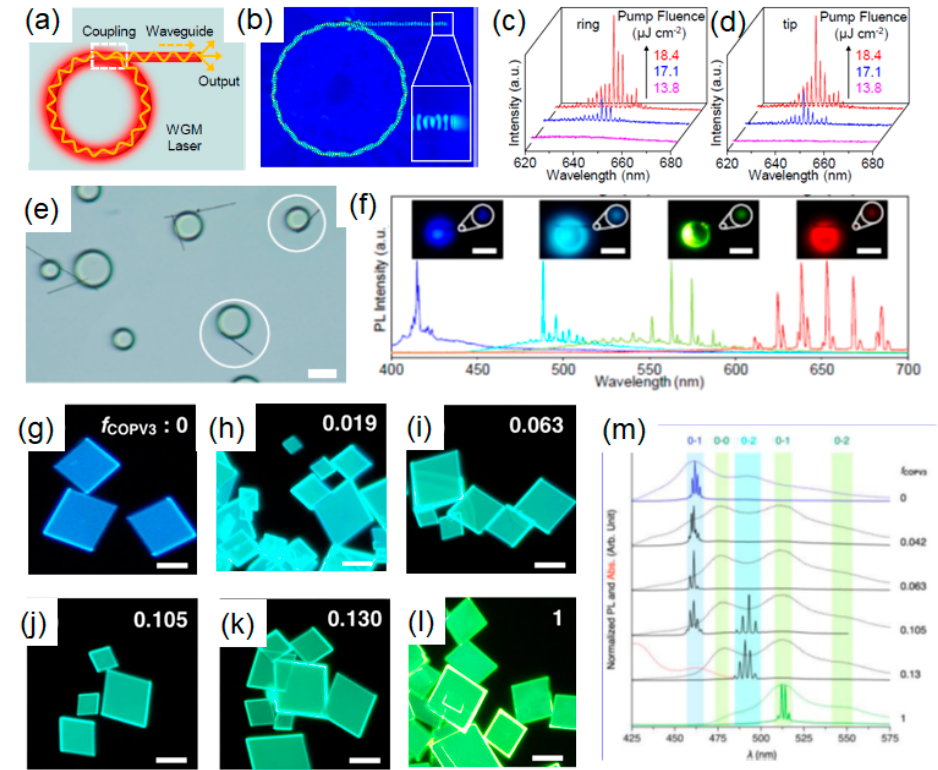
Figure 15. ( a ) Micro-ring coupled to a microbelt. ( b ) Optical simulation of the electric field inside the structure showing its distribution along the ring and the microbelt. ( c ) Laser emission detected from the ring and ( d ) from the microbelt tip. Reproduced with permission from ref. [122]. Copyright 2019, American Chemical Society. ( e ) Scanning electron microscopy images of microdisks coupled to plasmonic Ag wires (scale bar 5 mm) and ( f ) laser emission output detected from the nanowire tip. Reproduced with permission from ref. [141]. Copyright 2017, American Chemical Society. ( g – l ) Fluorescence image of rhombic COPV2:COPV3 co-crystals with different COPV3 content (scale bars 10 mm) and ( m ) tuning of laser emission by FRET in the co-crystals. Reproduced with permission from ref. [140]. Copyright 2018, American Chemical Society.